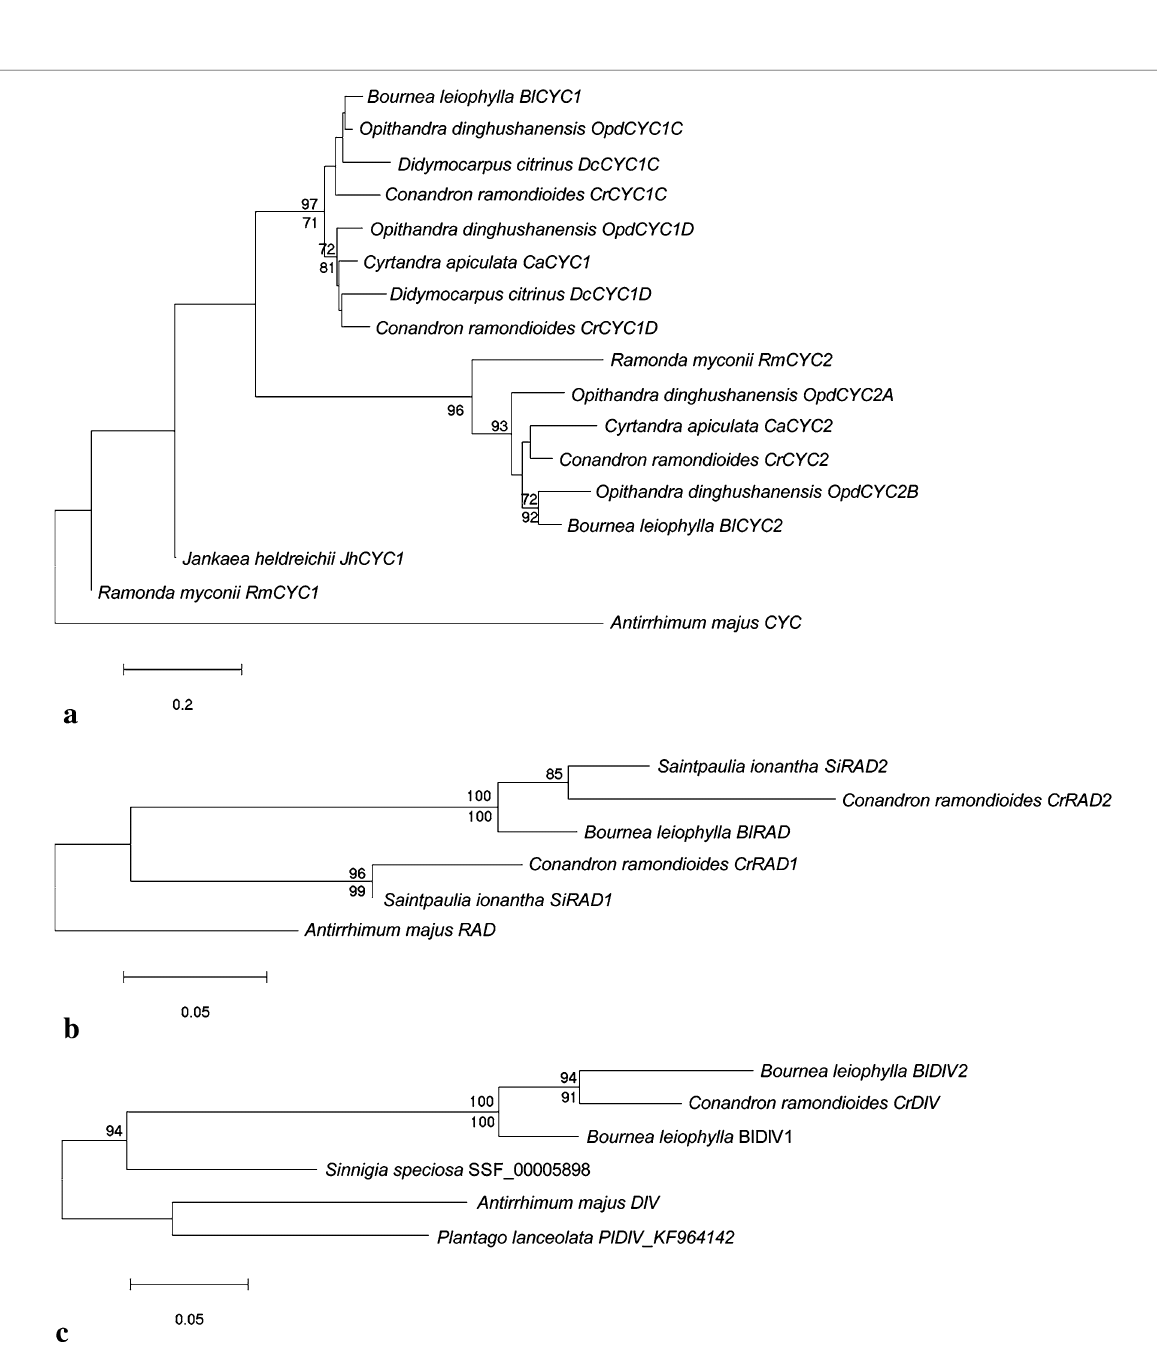
Fig. 4 Neighbour‑joining trees of CYC ‑like, RAD ‑like and DIV ‑like genes. Trees from a to c are reconstructed based on amino acid sequences. a CYC is from A. majus , others are CYC ‑like genes from Gesneriaceae species (see Additional file 2: Table S2). Trees show CrCYCs cluster into three groups with high support. b The tree shows CrRADs cluster into two distinct clade with high support. c Bootstrap values from NJ and ML are listed above and below branches respectively. Bootstrap values > 70 are shown. Detailed sequences information is listed in Additional file 2: Table